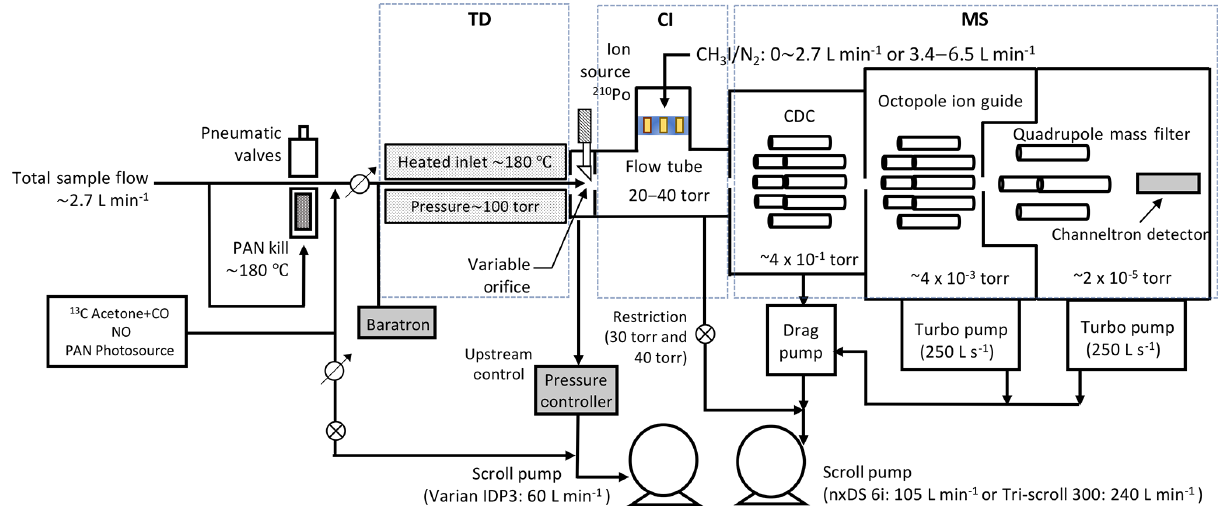
Figure 2. Schematic diagram of the TD-CIMS. Air is sampled through the TD (thermal dissociation) region and enters the flow tube through the AVO (automatic variable